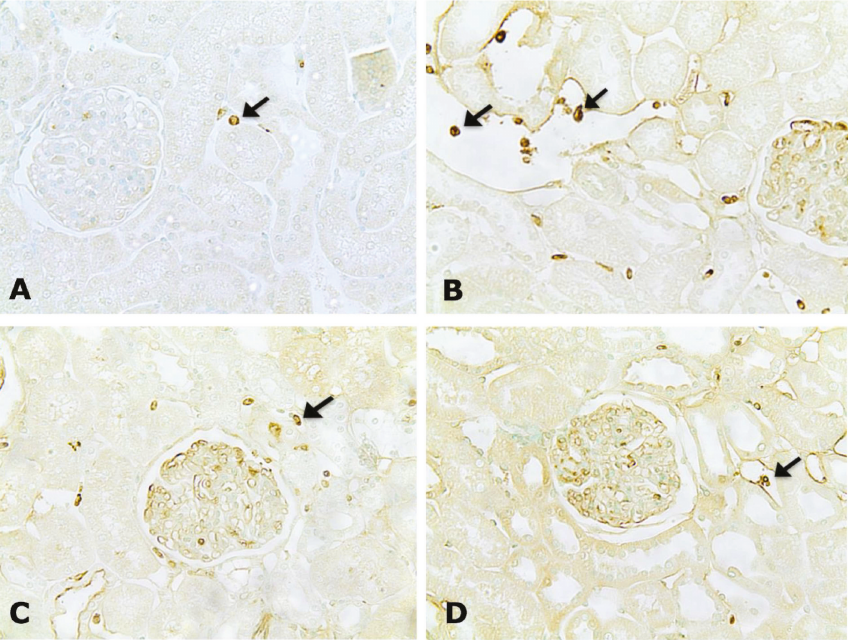
Figure 3: Immunolocalization of ED-1 in the renal cortex of SC (a), SD (b), TD (c), and PTD (d) rats. Note the less intensity of ED-1 immunostainings in PTD. Original magni fi cation ×